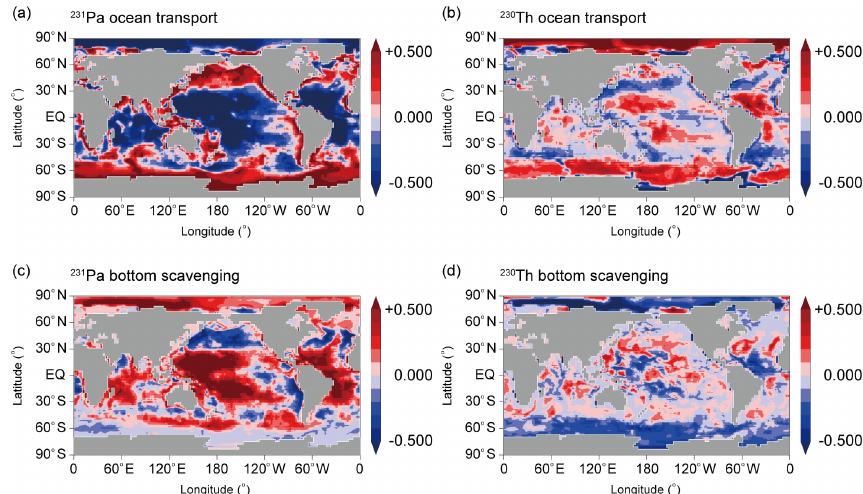
Figure 9. Sedimentary 231 Pa / 230 Th ratios normalized by the production ratio of 0.093 in CTRL_EXP decomposed into contributions from (a) ocean transport solely from 231 Pa (i.e., 231 Pa(3D) / 230 Th(1D)), (b) ocean transport solely from 230 Th (i.e., 231 Pa(1D) / 230 Th(3D)), (c) bottom scavenging solely from 231 Pa (i.e., 231 Pa(CTRL) / 230 Th(3D) minus 231 Pa(3D) / 230 Th(3D)), and (d) bottom scavenging solely from 230 Th (i.e., 231 Pa(3D) / 230 Th(CTRL) minus 231 Pa(3D) / 230